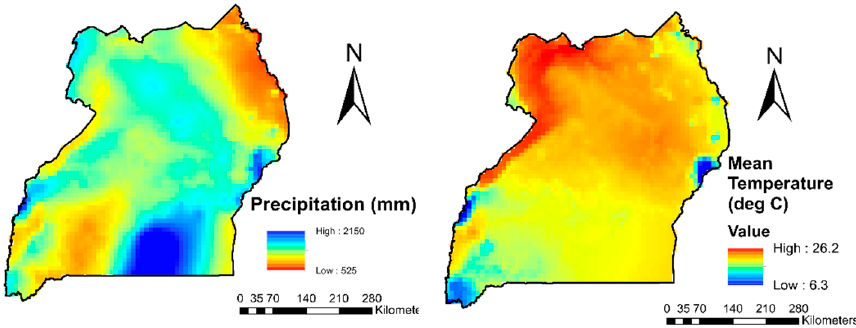
Figure 2. Mean annual precipitation (mm) and average temperature (°C).